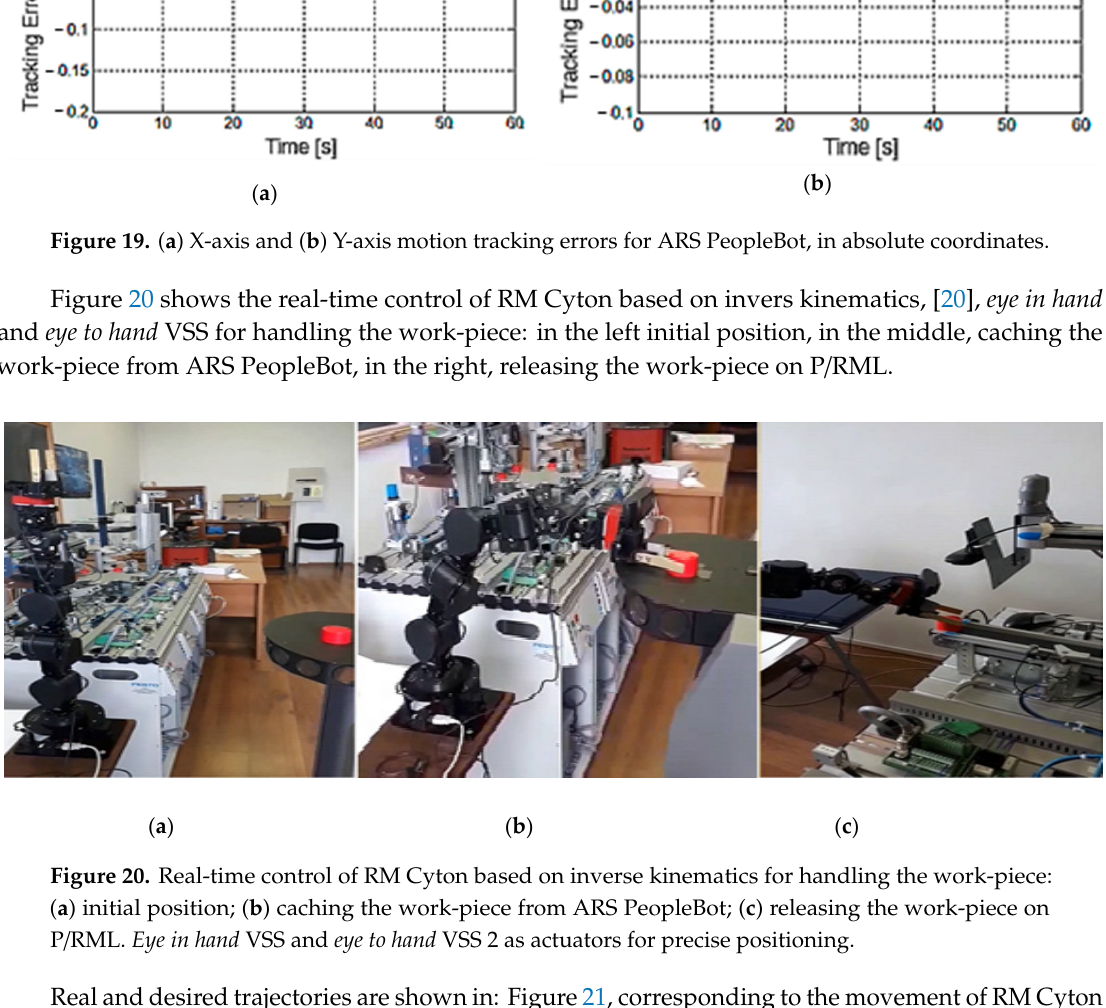
Figure 18. Real and desired trajectory of ARS PeopleBot based on trajectory tracking sliding-mode control.